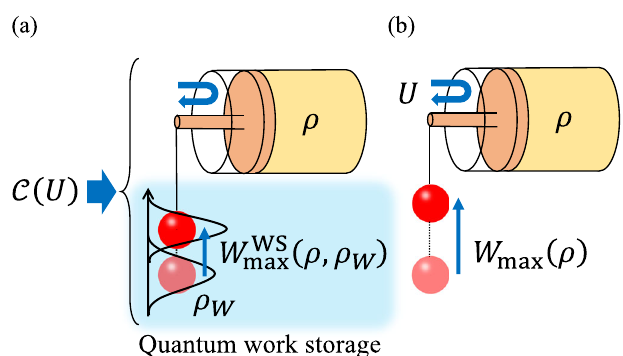
FIG. 4. Work extraction in the setups (a) with and (b) without the work storage. C ð U Þ is a unitary operator acting on the composite system of the system and the work storage, which is defined by a unitary operator U acting only on the system through the Kitaev construction Eq. (13). C ð U Þ is constructed such that it satisfies energy conservation of the composite system and energy translation invariance of the work storage. Moreover, C ð U Þ gives a one-to-one correspondence between the possible operations in the setups with and without the work storage. As shown in Eqs. (19) and (20), the maximal extracted work with the work storage is no greater than that without the work storage. If U satisfies ½ U † HU; H (cid:2) ¼ 0 , the extracted work from ρ without the work storage is the same as that from ρ with the work storage by unitary operation C ð U Þ independently of the work storage ρ which is stated in Proposition